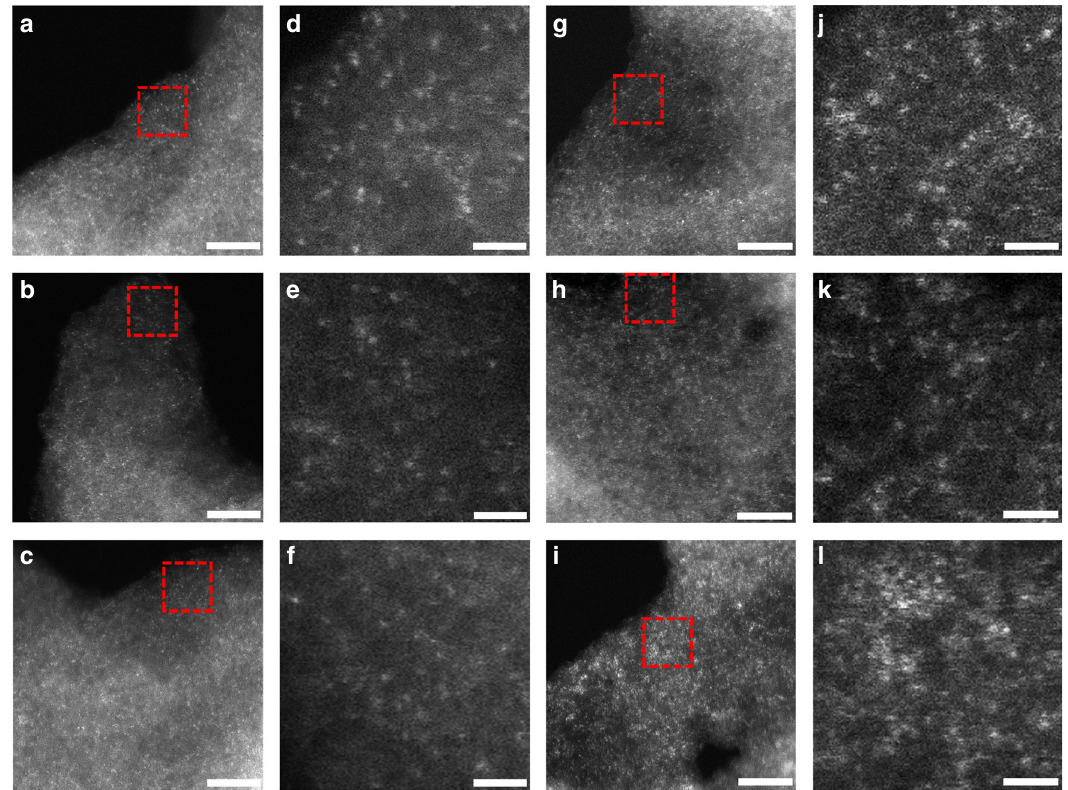
Fig. 2 HAADF-STEM images of Ni/GD and Fe/GD. a – c Examination of various regions reveal that only isolated Ni atoms (white dots) are present and uniformly dispersed on the GD. Scale bars, 5 nm. d – f Corresponding enlargement of the marked regions in a – c . Scale bars, 1 nm. g – i Examination of various regions reveal that only isolated Fe atoms (white dots) are present and uniformly dispersed on the GD. Scale bars, 5 nm. j – l Corresponding enlargement of the marked regions in g – i . Scale bars, 1